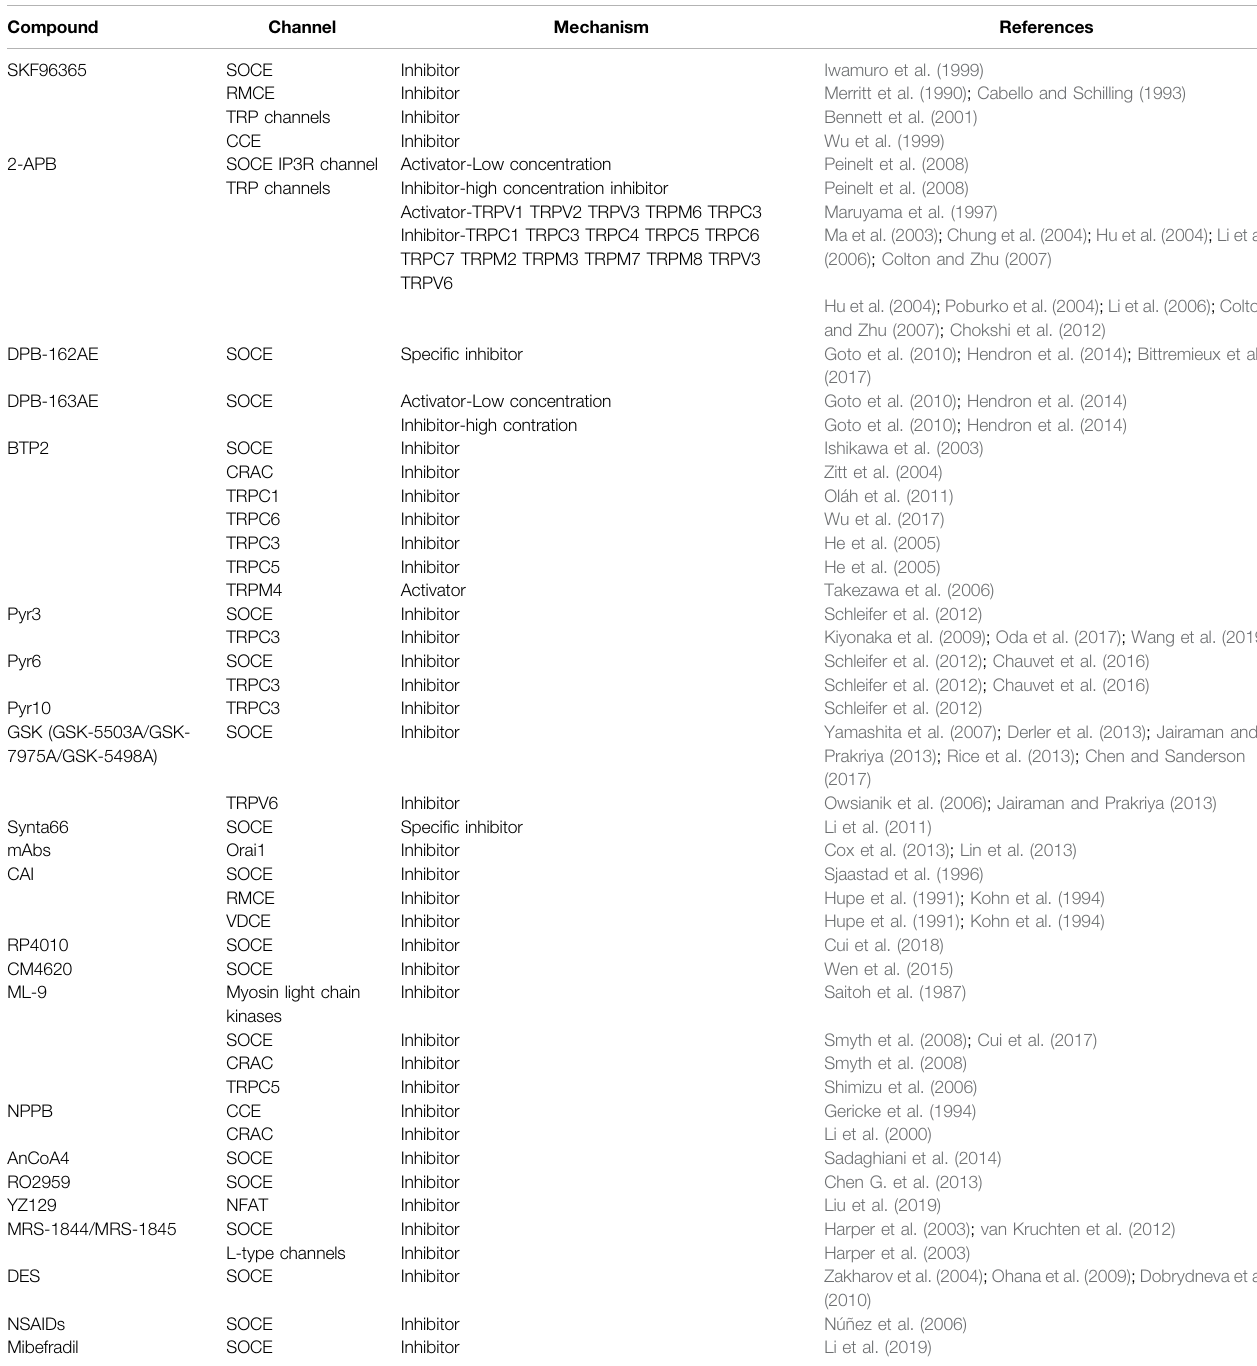
TABLE 2 | Targeting channels of